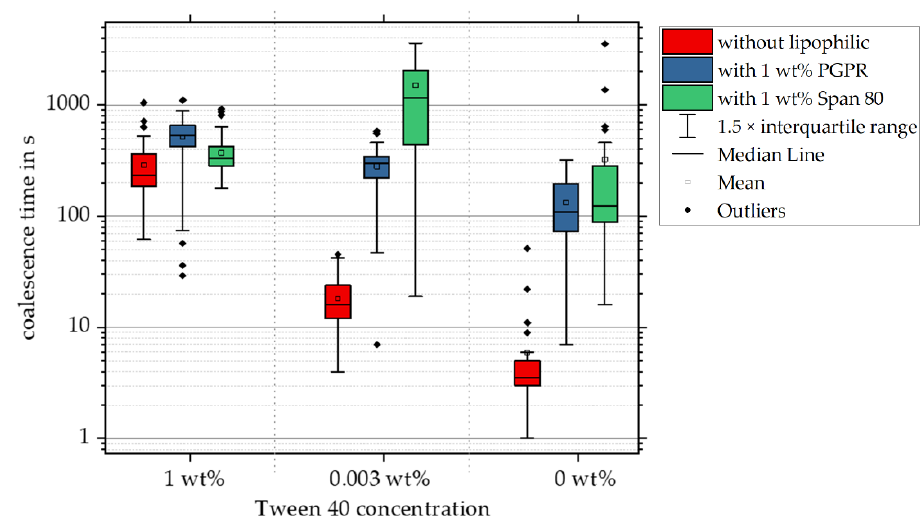
Figure 4. Coalescence time of single droplets in box plot diagram form. The box shows the middle quartiles, while the whiskers mark the upper and the down quartile. Additionally, the outliers and mean value are plotted. On the x-axis, the concentration of Tween 40 is varied. In the oil phase, either PGPR, Span 80 or no lipophilic surfactant were added. With decreasing concentrations of Tween 40, the stability of oil droplets decreases. Additional lipophilic surfactants can help to stabilize the water droplets.